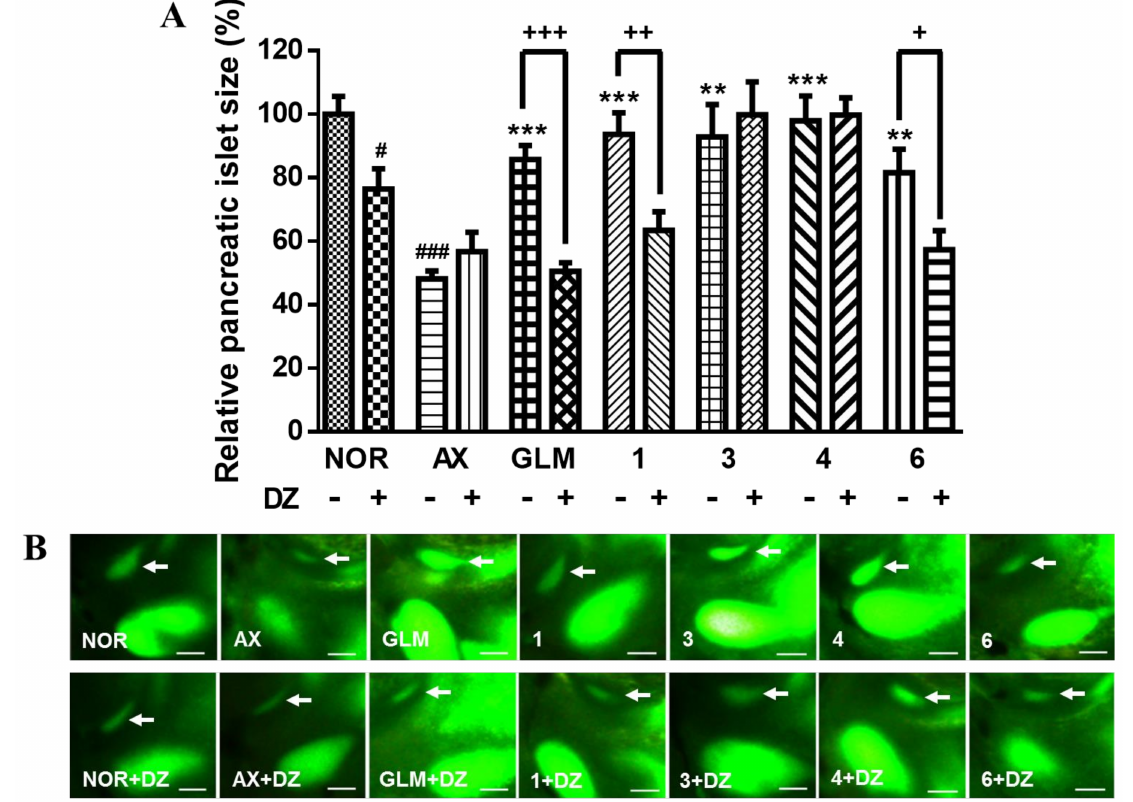
Figure 4. Recovery effects of flavonoids 1 , 3 , 4 , and 6 on zebrafish larvae treated with alloxan (AX) and diazoxide (DZ). Glimepiride (GLM) was used as a positive control. ( # p < 0.05, ### p < 0.001; compared to NOR), (** p < 0.01, *** p < 0.001; compared to AX), ( + p < 0.05, ++ p < 0.01, +++ p < 0.001). ( A ) Recovery effects of flavonoids 1 , 3 , 4 , and 6 on zebrafish larvae treated with AX and DZ. ( B ) Fluorescent microscopic images of PIs treated with compounds 1 , 3 , 4 , and 6 following treatment with 2-NBDG